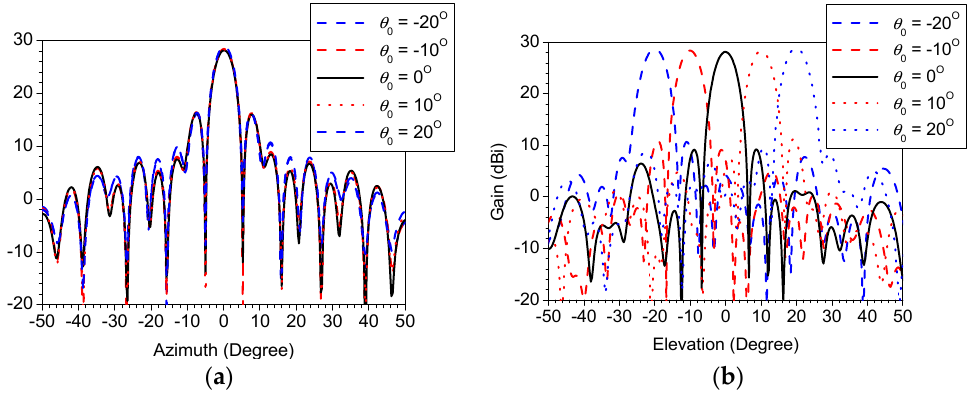
Figure 16. Antenna radiation patterns by the full scan method: ( a ) azimuth plane and ( b ) elevation plane.